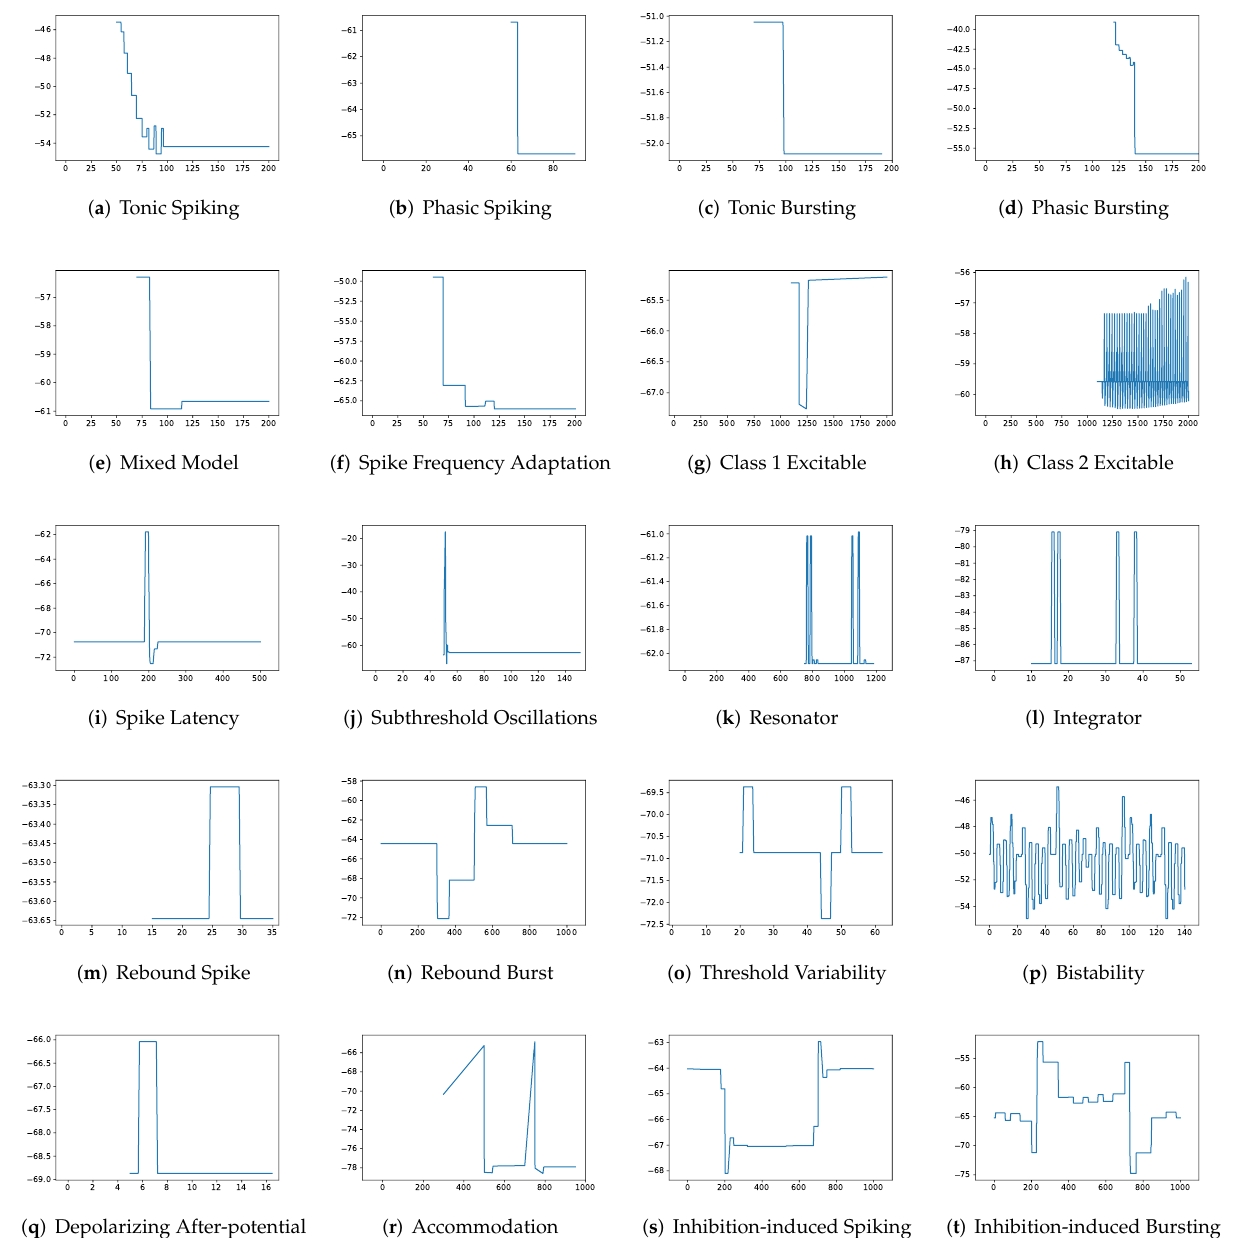
Figure 7. Membrane potentials of RSRM, where y-axis is the membrane potential (mV) and x-axis is the time